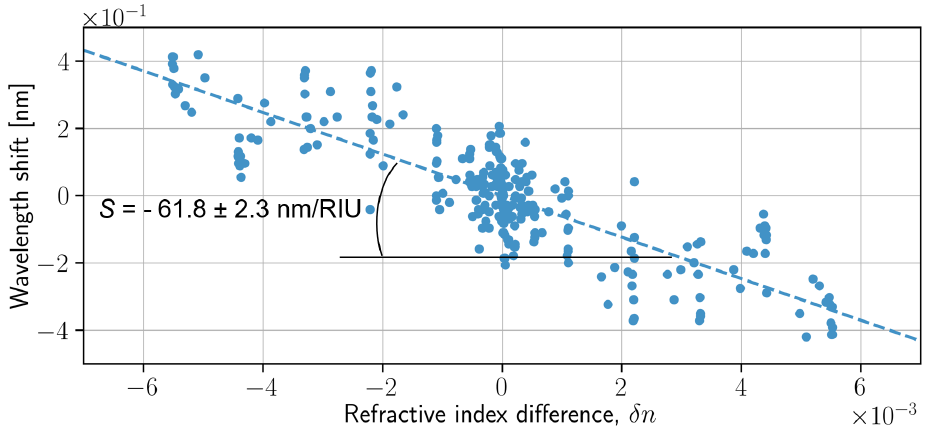
Figure 5. Dependence of the spectra shift on the refractive index